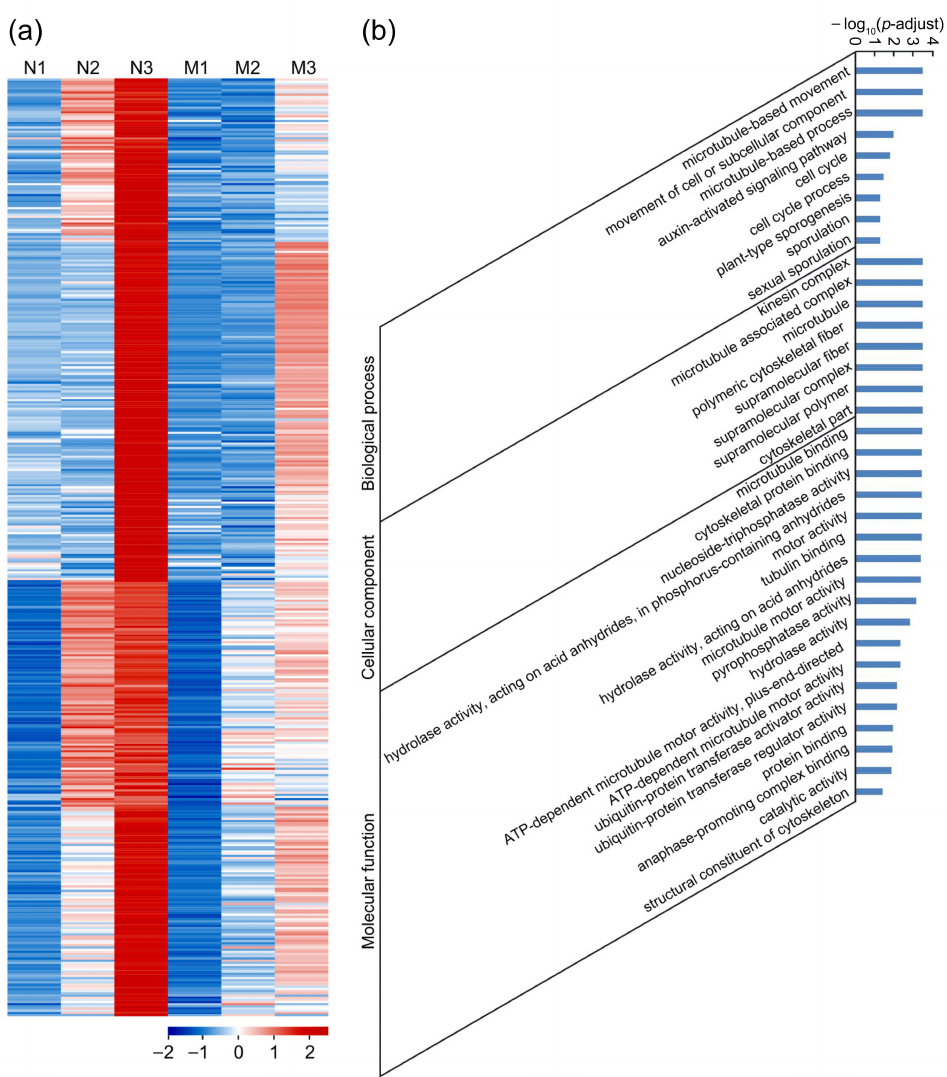
Figure 8. Expression patterns and GO enrichment analysis of the 430 genes involved in zygote formation and free endosperm nuclear division in rice. ( a ) Heat map of the 430 genes, showing significantly upregulated in N3 compared with N2, and significantly downregulated in M3 compared with N3. ( b ) GO enrichment analysis of the 430 genes. N1, WT pistil at 1–20 min after pollination; N2, WT pistil at 3.5 HAP; N3, WT pistil at 8 HAP; M1, the mutant pistil at 1–20 min after pollination; M2, the mutant pistil at 3.5 HAP; M3, the mutant pistil at 8